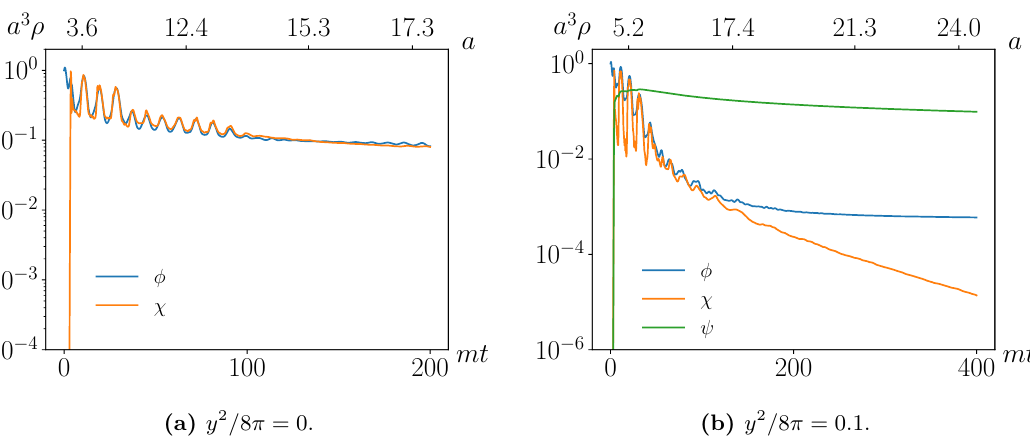
Figure 2. Time evolution of φ , χ , and fermionic fluid energy density for b = 0 . 9 , m = 10 − 6 M pl , Φ = f = M , q = 200 and y 2 / 8 π = 0 or 0.1. When y is nonzero, energy transfer continues to 0 pl 0 happen after ρ becomes comparable with ρ . This second stage of energy transfer stops eventually χ φ when the system leaves the tachyonic resonance band. The smaller y is, the longer it takes to reach this stop. The total comoving energy density is not conserved here because the equation of state of the system quickly deviates from being matter-like, as shown in figure